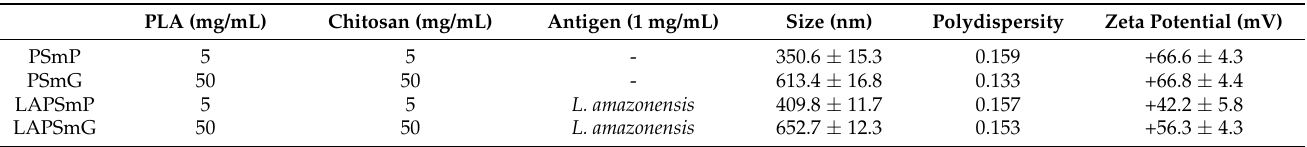
Table 1. Characteristics of the SMP